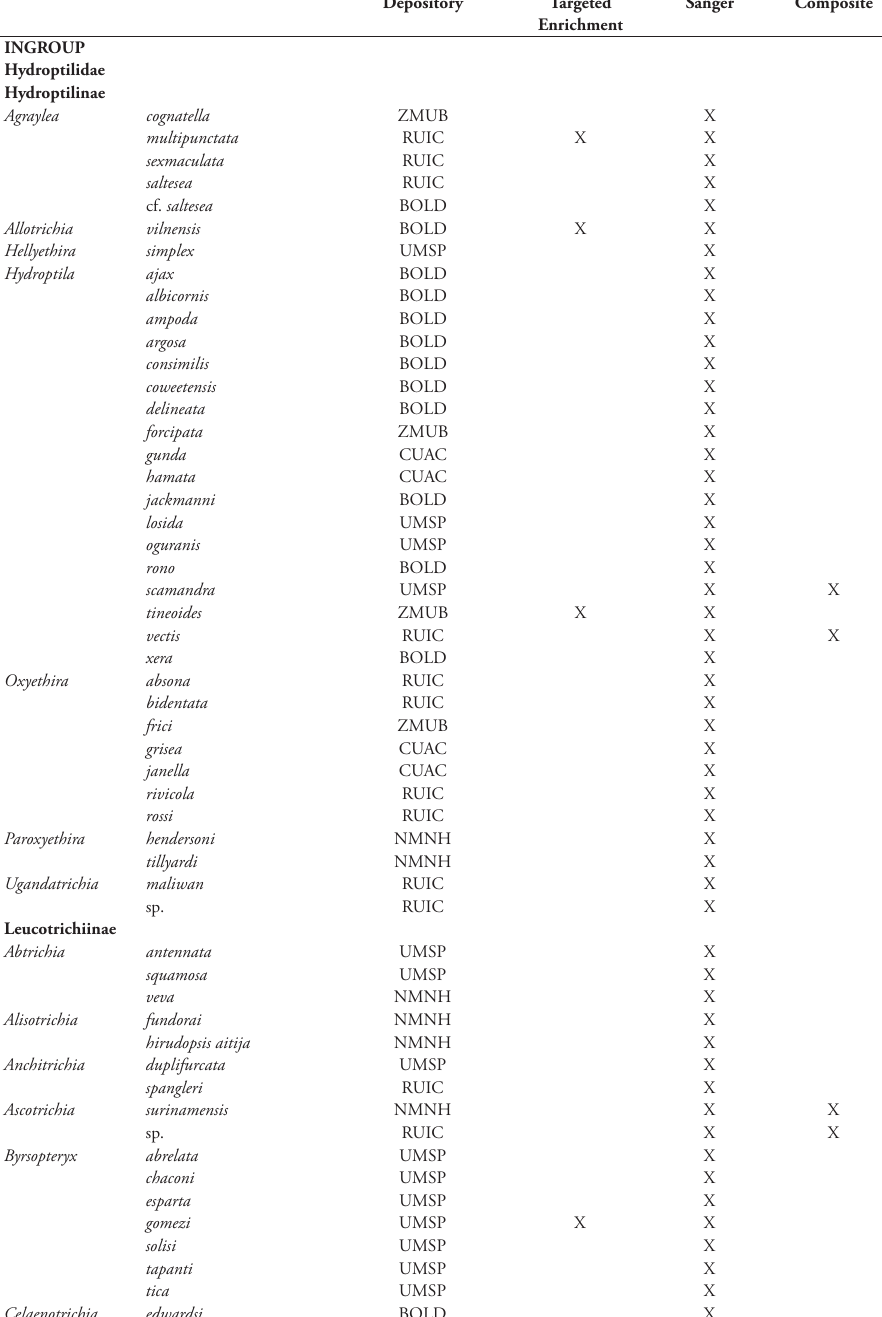
Table 2. Determination, depository, and sequencing method of specimens included in phylogenetic analyses. “Composite” refers to instances in which we combined sequence data for two closely related species in the same genus for the sake of matrix